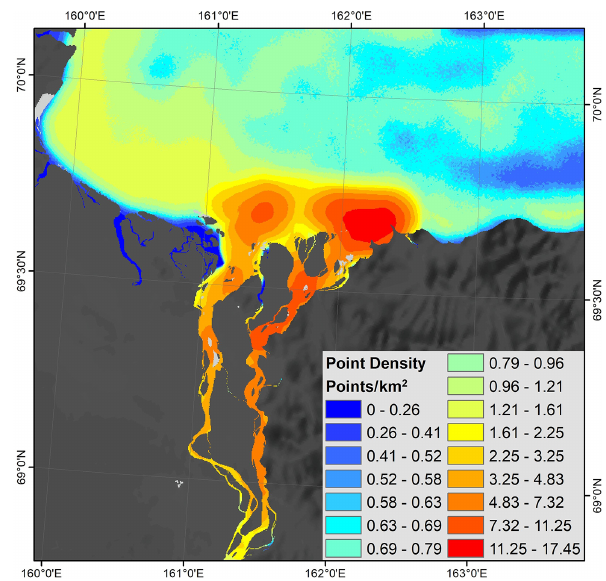
Figure D2. Point density for Kolyma Gulf bathymetrical models (TTR 50 + TTR 200 ), indicating the higher point density in the Kolyma main